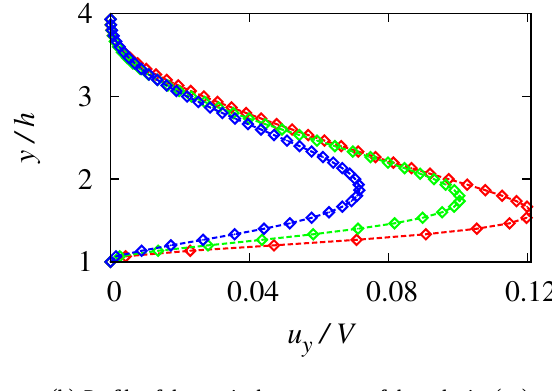
Figure 9: Profiles of the components of the velocity vector at the ver- tical section located at x = L /2 for different values of the Reynolds number, i.e. R = 15 (green), 50 (blue), 100 (red). Reference so- lutions and present findings are indicated by dashed lines and diamonds,